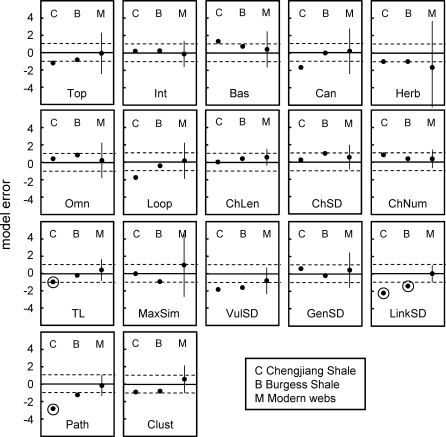
Comparison of Niche Model Errors for Cambrian and Modern Food Webs for 17 Structural PropertiesFor each property, individual ME values are shown for two Cambrian webs, followed by confidence intervals (CI) for eight modern webs, indicated by mean ME ±2.365 standard deviations (SD). Circles around four Cambrian data points indicate Cambrian web MEs that fall outside modern web CIs. 2.365 is the critical value from the t-distribution for seven degrees of freedom at a quantile of 97.5% for a two-tailed test. Dashed horizontal lines show ±1 ME boundaries, solid lines show ME = 0. MEs that fall within ±1 are considered to show a good fit of the model to the data.